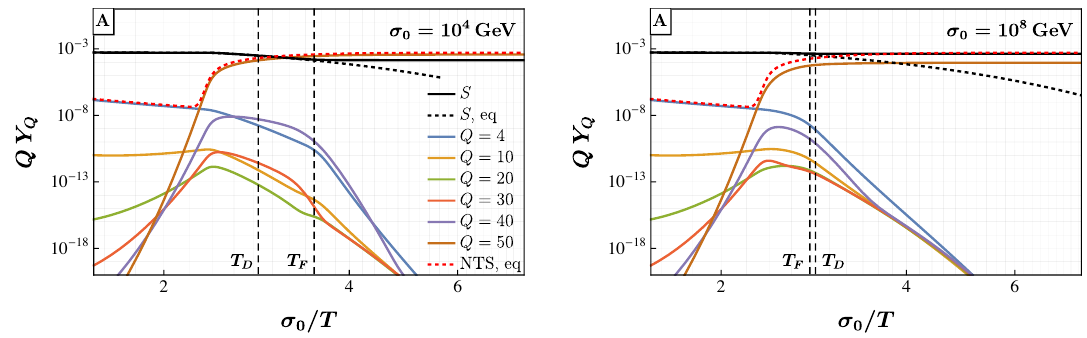
Figure 3 . Evolution of charge yields Y Q ≡ n Q /s for a few species in Model A after solving the full set of Boltzmann equations. The left panel with σ 0 = 10 4 GeV has Q-ball charge dominance, while the right panel with σ 0 = 10 8 GeV has S dominance. Both plots use η = 0 . 1 , Q min = 4 , and Q max = 50 . The vertical dashed black lines represent the freeze-out temperature T F estimated from (3.20) and the analytic expression for T D from (3.10) if chemical equilibrium were maintained. The dotted black and red curves show the evolution of the equilibrium charge yields of the S particle and NTS,